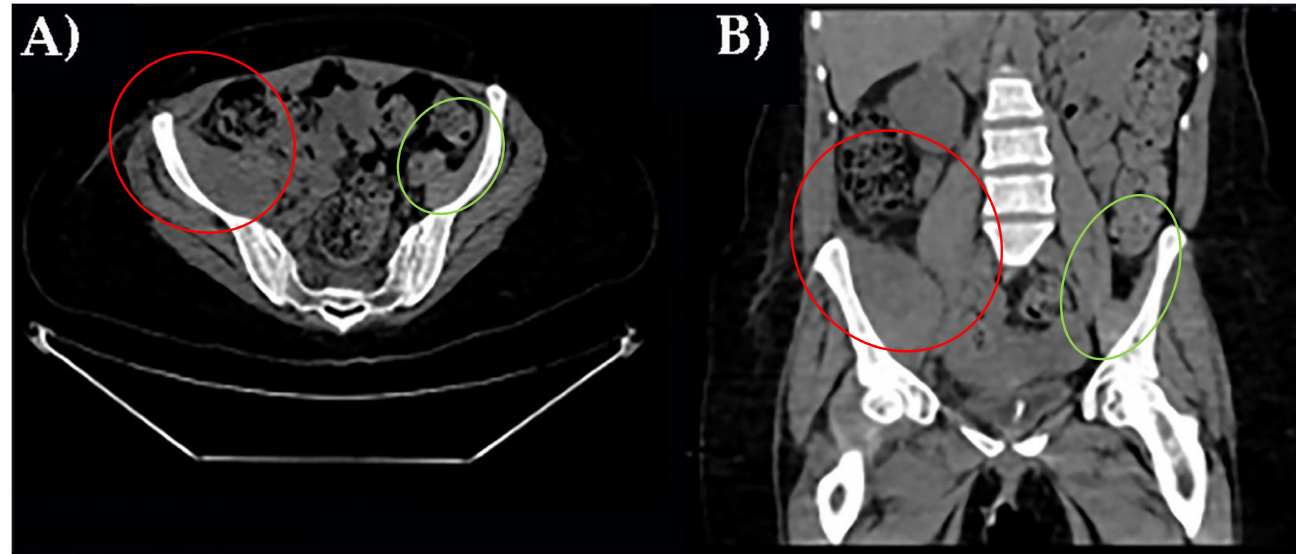
Figure 1. CT axial scan of the pelvis with right ileal muscle hematoma. ( A ). CT coronal scan of the pelvis with right ileal muscle hematoma ( B ). In red, pathological finding; in green, normal